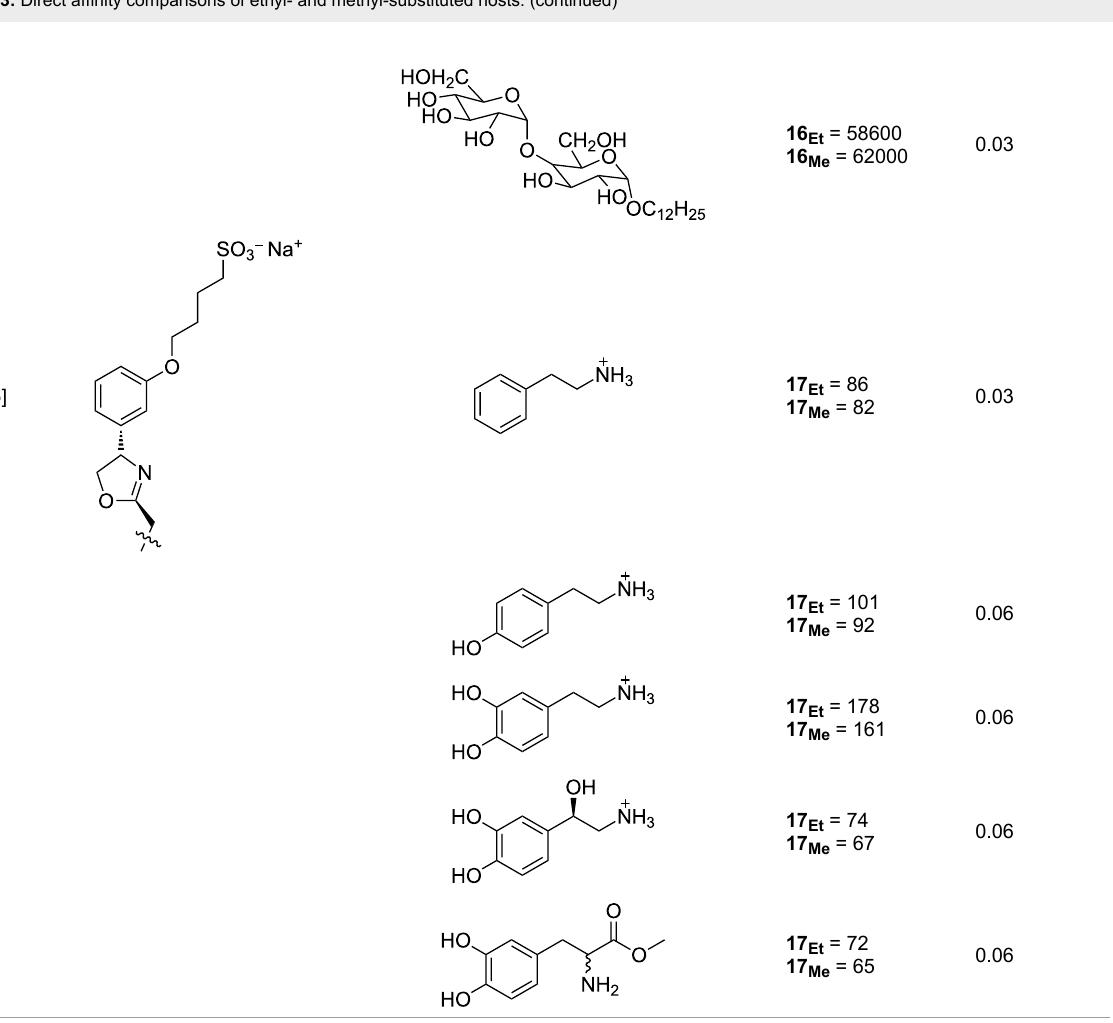
substructures (Figure 3) to retrieve records for all related organic molecules, and discarded from our analysis those whose conformations were predetermined by macrocyclizations (and that therefore were not under the control of steric gearing).